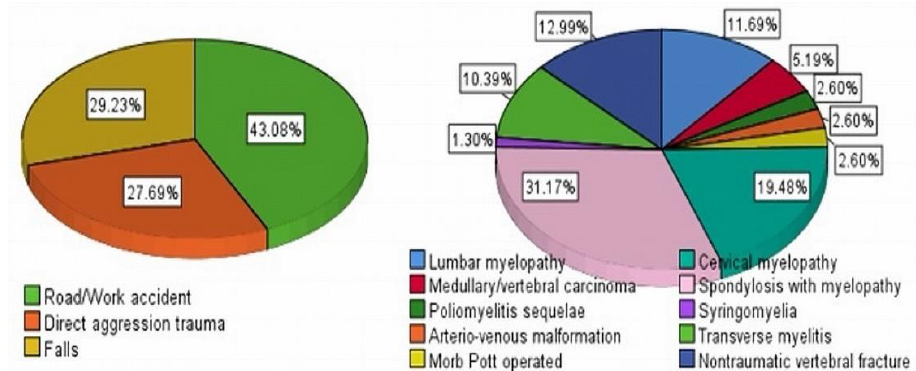
Figure 1. Causes of T-SCI ( left ) and causes of NT-SCI ( right ).